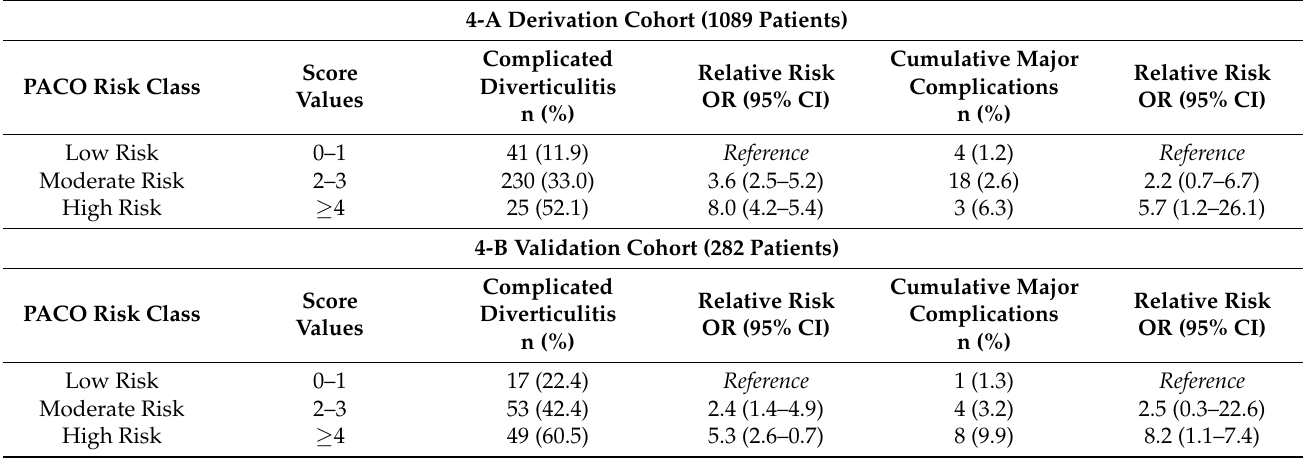
Table 4. Summary of the proposed PACO-D score on derivation cohort (4-A) and on validation cohort